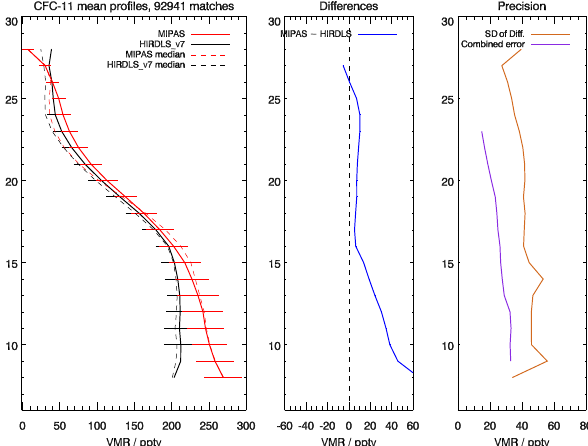
Figure 6. Correlation of collocated MIPAS CFC-11 measurements with HIRDLS measurements during the time period of 2005 to 2008.